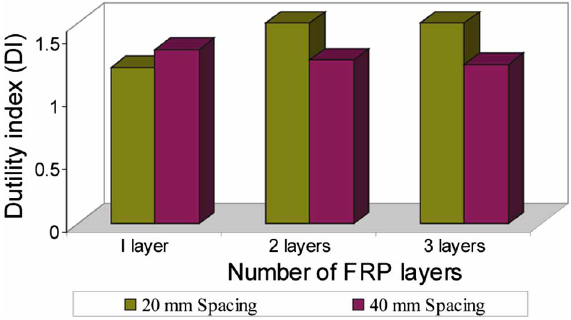
Fig. 22. Ductility Index for all columns (cid:1)